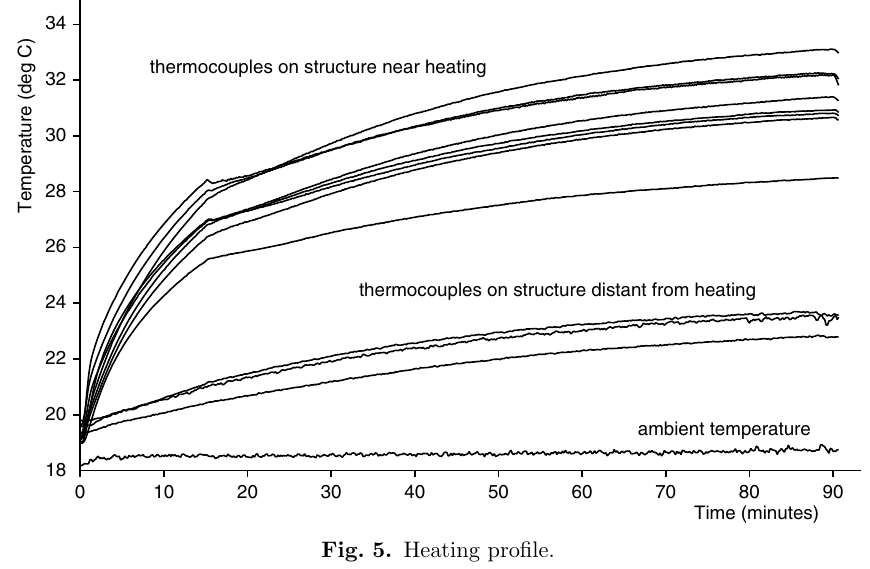
Fig. 5. Heating pro fi le.